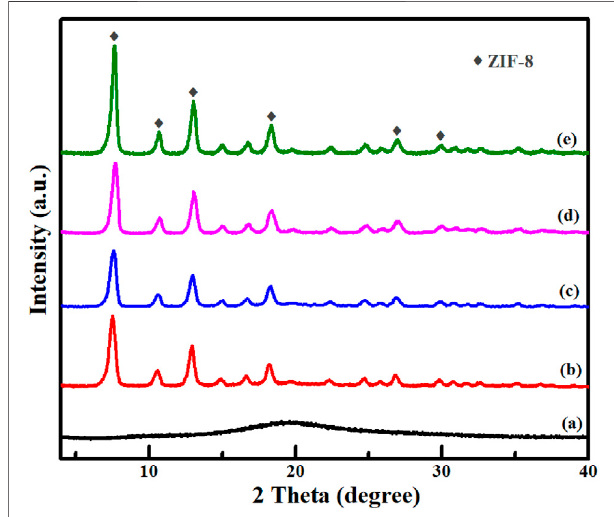
FIGURE 5 | Powder XRD patterns of (A) SPS; (B) SPS|ZIF-8; (C) SPS|(Au)ZIF-8; (D) SPS|(Au)ZIF-8|ZIF-8 and (E) Void|(Au)ZIF-8|ZIF-8.